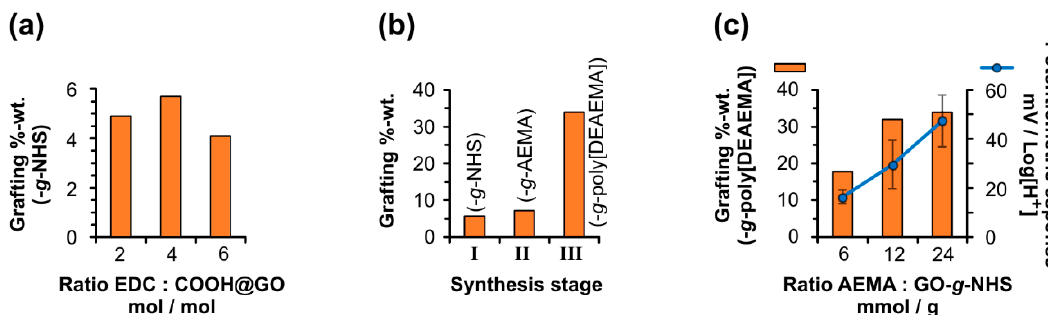
Figure 1. Grafting degree of graphene oxide (GO) depending on the reactant ratios at different stages: ( a ) N ‐ hydroxysuccinimide (NHS) ‐ ester amount introduced after varying N ‐ ethyl ‐ N ′‐ (3 ‐ dimethylaminopropyl)carbodiimide (EDC) against the molar content of COOH per sample of GO (COOH@GO), for an NHS:EDC molar ratio = 2 in all the cases. ( b ) Material history in terms of graft content for a selected ratio EDC:COOH@GO of 4 mol/mol at Stage I, subsequently modified with amide ‐ linked polymerizable 2 ‐ aminoethyl methacrylate (AEMA) moieties under a ratio of 24 mmol/g of AEMA vs. the departing material GO ‐ g ‐ NHS at Stage II, and its further polymerization with a five ‐ fold excess in weight of 2 ‐ (diethylamino)ethyl methacrylate (DEAEMA) against GO ‐ g ‐ AEMA in Stage III. ( c ) Amount of poly[DEAEMA] chains incorporated to GO after Stage III for a fixed five ‐ fold excess in weight of DEAEMA vs. GO ‐ g ‐ AEMA, but a variable ratio in AEMA vs. GO ‐ g ‐ NHS at Stage II and an initial molar ratio EDC:COOH@GO = 4 mol/mol at Stage I; in ( c ), a preliminary potentiometric evaluation of the material in a flexible solid ‐ state sensor format showed a positive correlation between polymer grafting degree and electrochemical response against Log[H + ].